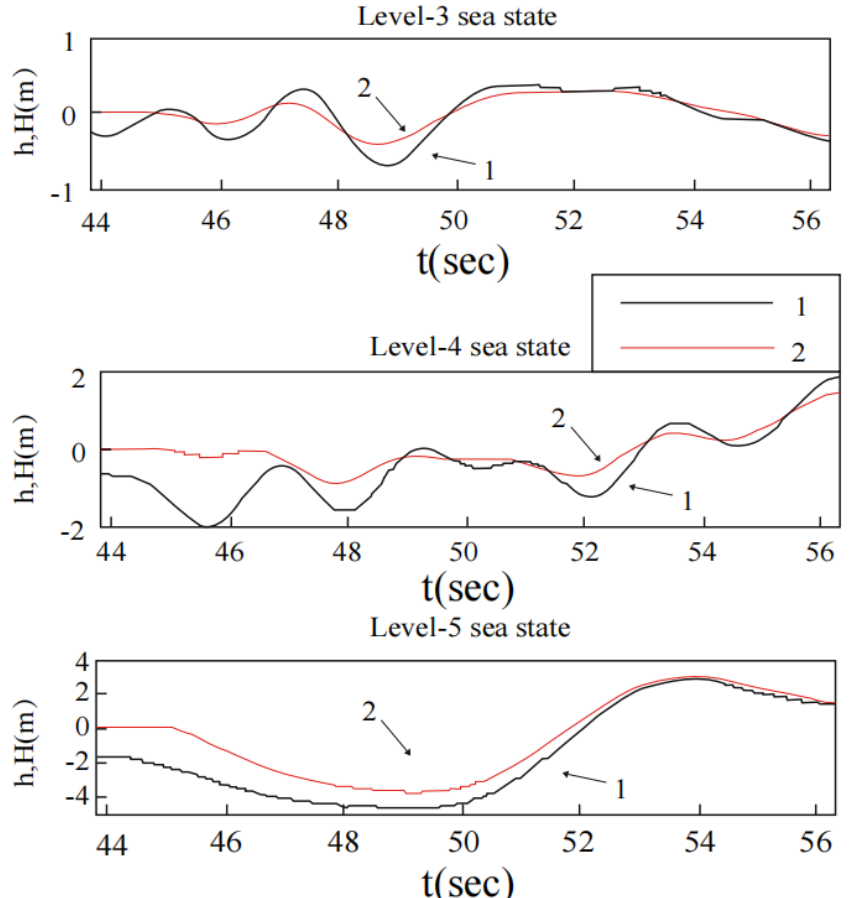
Figure 15. The response curves of carrier-borne aircraft tracking the vertical motion of ideal landing point under different states of sea scale.